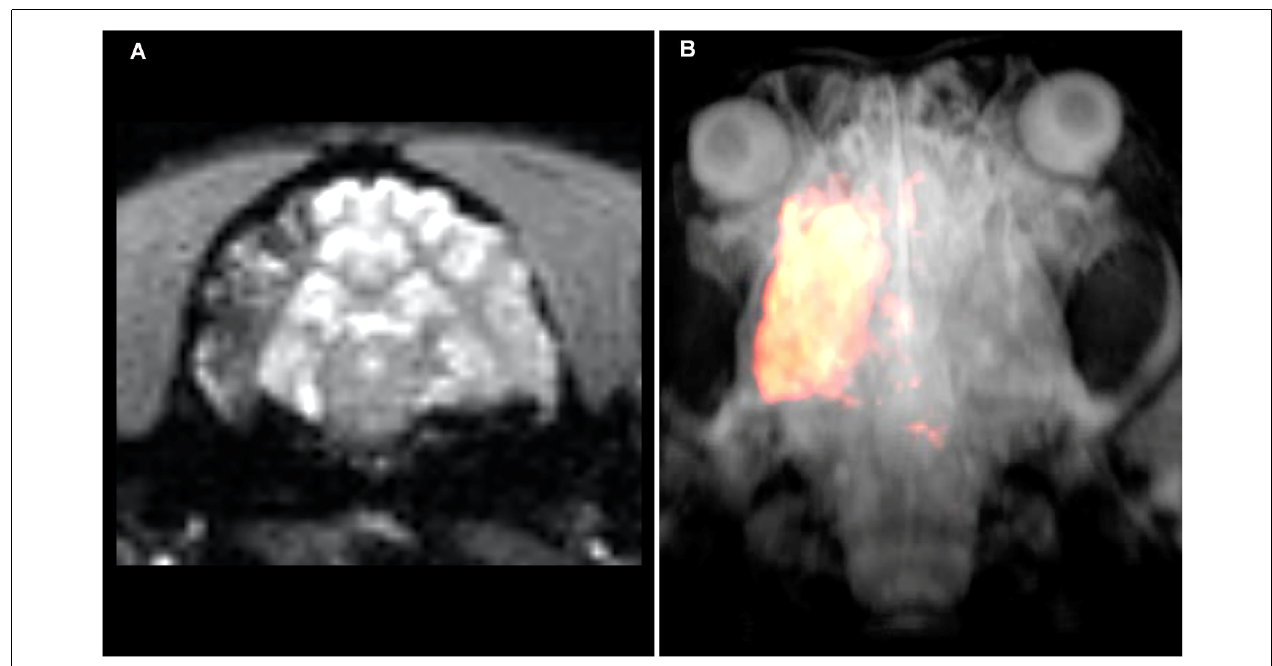
FIGURE 2 | Intraarterial magnetic resonance imaging (MRI)-guided injection of mesenchymal stem cells into the canine brain. (A) Raw T2*w MRI after intraarterial injection of superparamagnetic iron oxide particle-labeled mesenchymal stem cells showing cell accumulation throughout the ipsilateral middle cerebral artery territory. (B) Segmentation of hypo-intense pixels and 3D visualization of stem cell biodistribution. Please see the Supplementary Video 1 for a dynamic visualization of stem cell